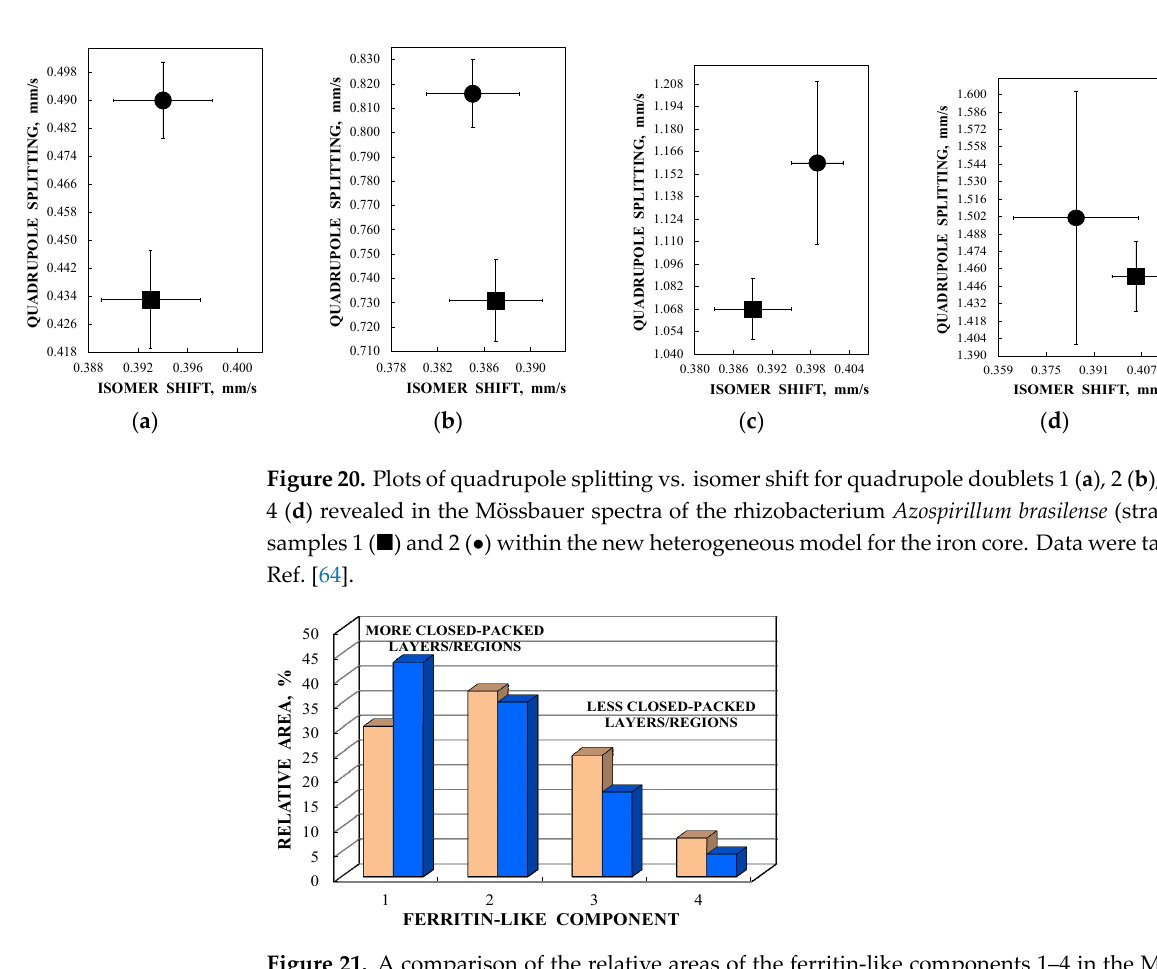
Figure 21. A comparison of the relative areas of the ferritin ‐ like components 1–4 in the Mössbauer spectra of the rhizobacterium Azospirillum brasilense (strain Sp245) samples 1 ( ■ ) and 2 ( ■ ). Data for sample 1 were recalculated accounting for the non ‐ ferritin ‐ like component 5. Adapted from Ref. [64] with permission from Elsevier: Journal of Molecular Structure, Vol. 1073, Alenkina I.V., Osh ‐